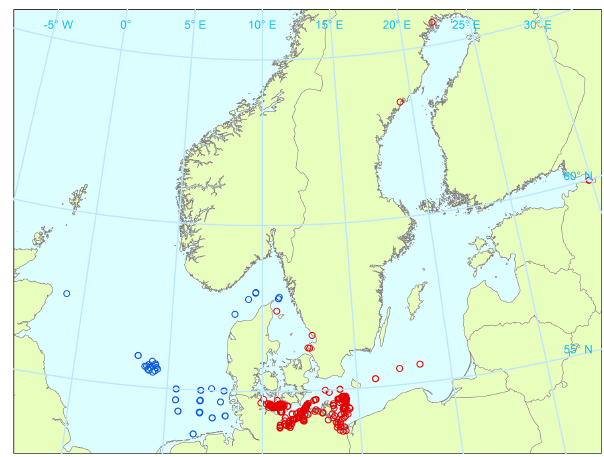
Figure 1. The geographical locations of sites where individuals were collected for reported measurements. Colour of symbols in- dicates habitats of the Baltic Sea (in red) and the North Sea (in blue). Data points may represent multiple observations at that lo- cality. Projection: ETRS89 Lambert azimuthal equal area.